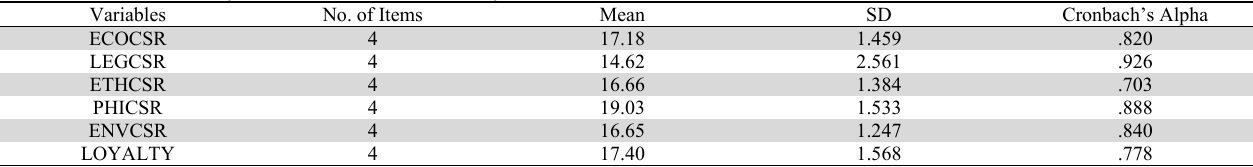
Mean Scores and Analysis of Internal Consistency Variables